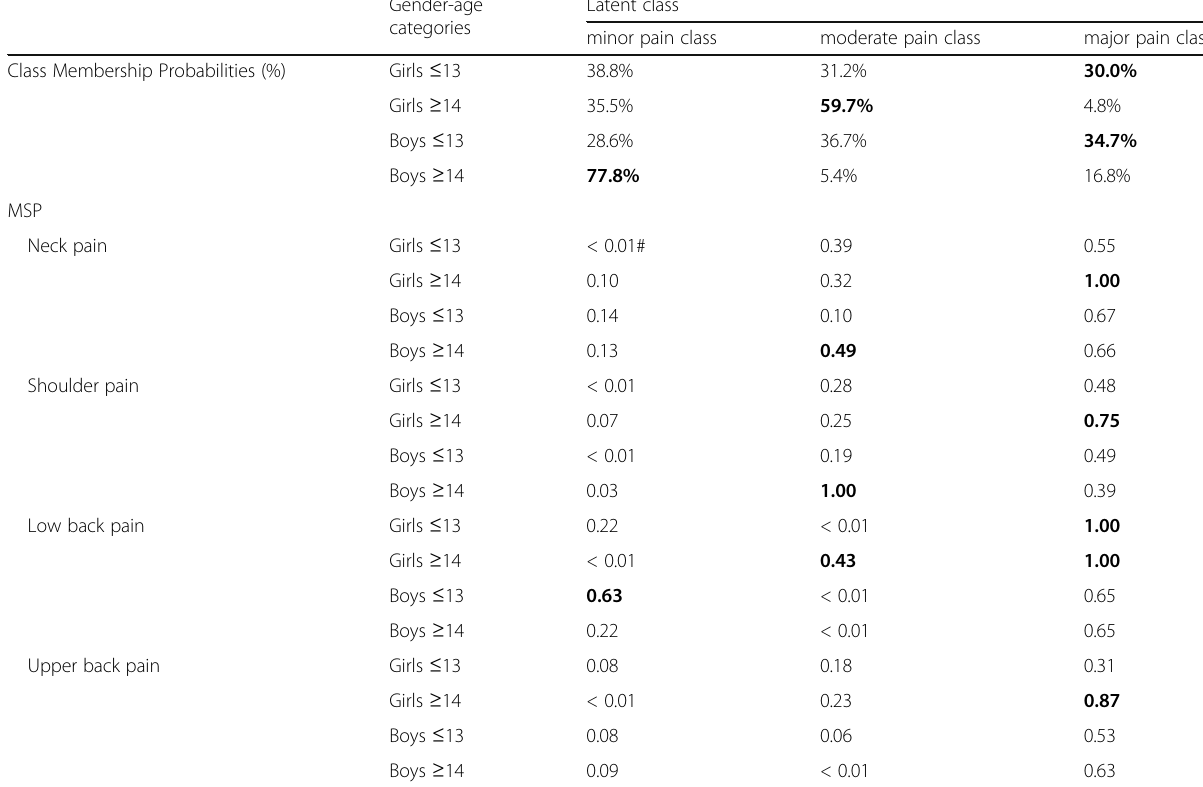
Table 5 Membership and item response probabilities in gender – age (combined) specific LCA